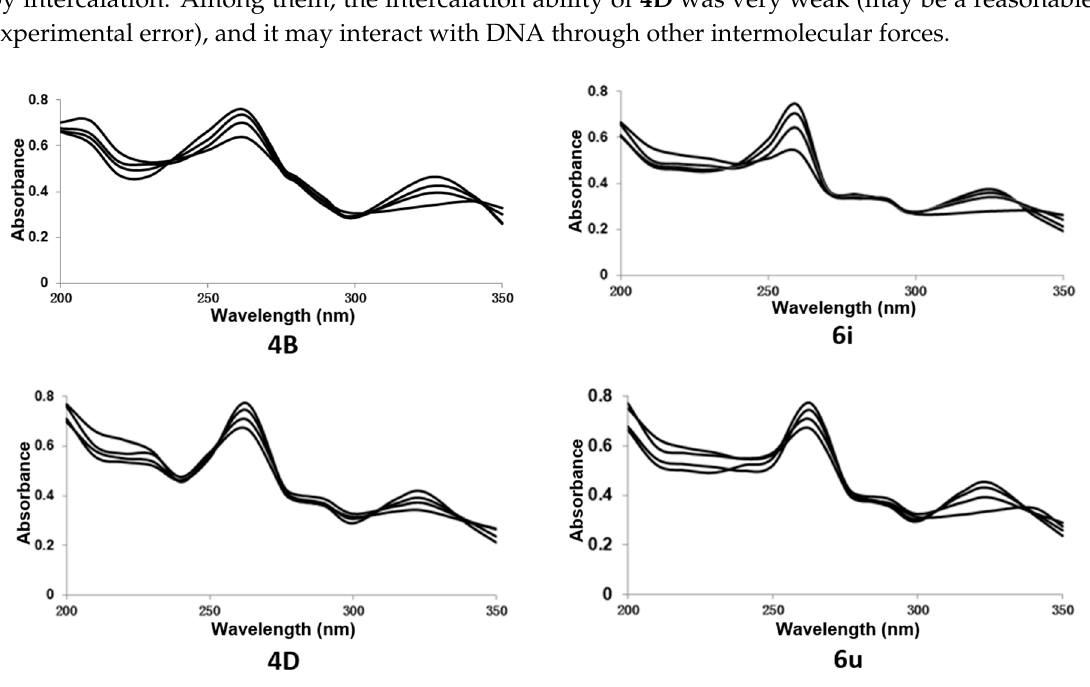
Figure 5. UV-visible spectroscopy study of β -carbolines with calf thymus (CT) DNA. UV-visible absorption titrations were done by adding 200 nM CT DNA solution each time to the quartz cuvette containing 10 μ M 4B , 6i , 4D , and 6u . The absorption spectra were recorded from 200 nm to 350 nm.